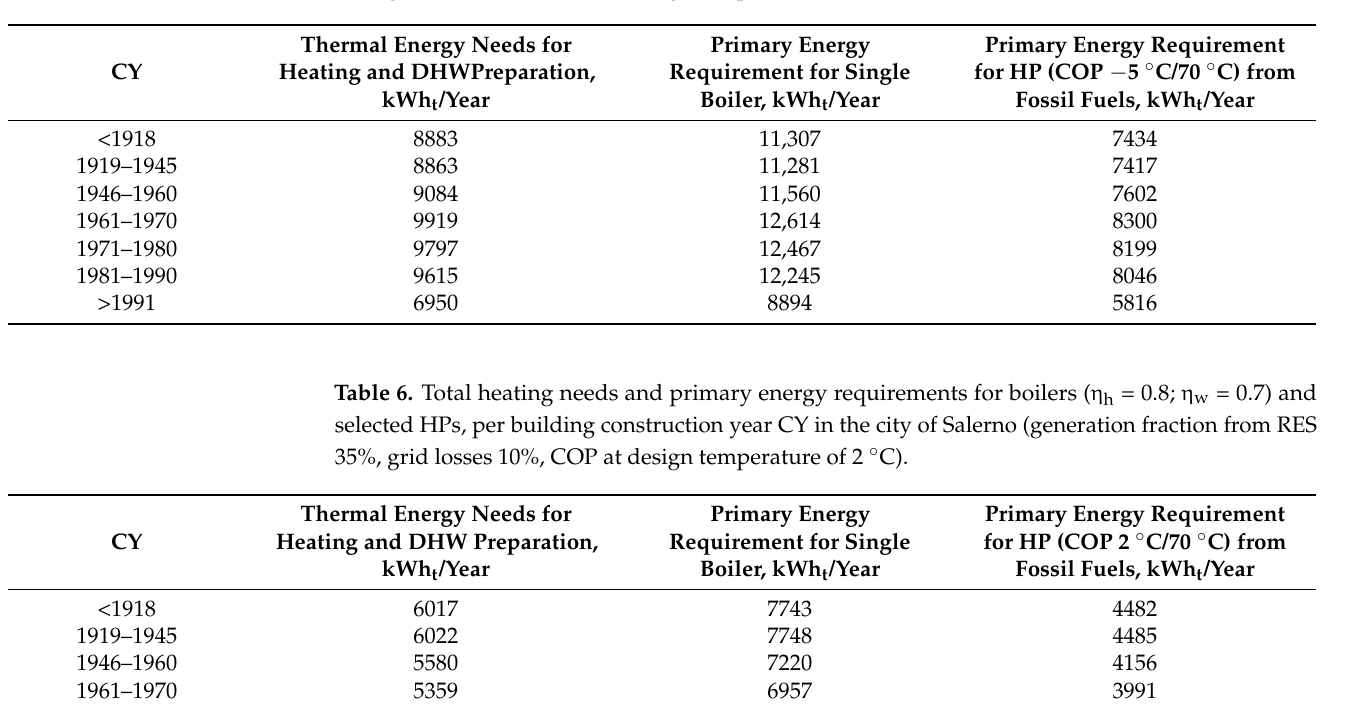
Table 5. Total heating needs and primary energy requirements for boilers ( η h = 0.8; η w = 0.7) and selected HPs, per building construction year CY in the city of Milan (generation fraction from RES 35%, grid losses 10%, COP at design temperature of − 5 ◦ C).